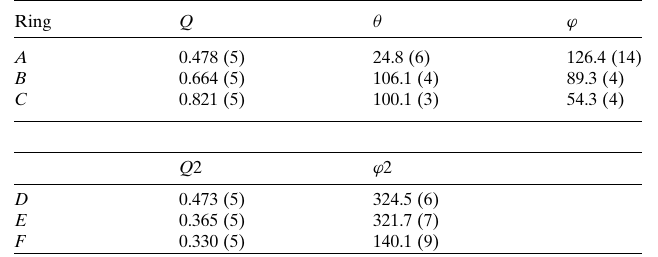
Puckering parameters (A˚ , (cid:3)